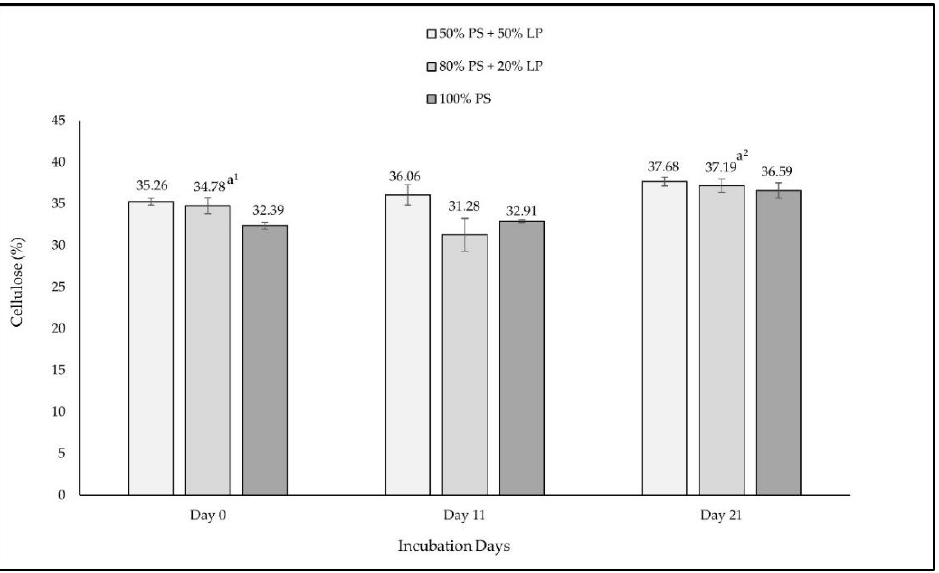
Figure 7. Evaluation of Cellulose content for PS and its mixtures with LPs Statistical analysis was performed for each substrate individually between Day 0 and Day 21. Different superscripts between the same letters indicate statistical significance ( p ≤ 0.05).